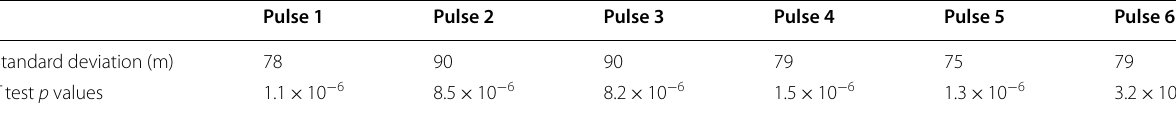
Table 2 Summary of error analysis conducted on ASL results